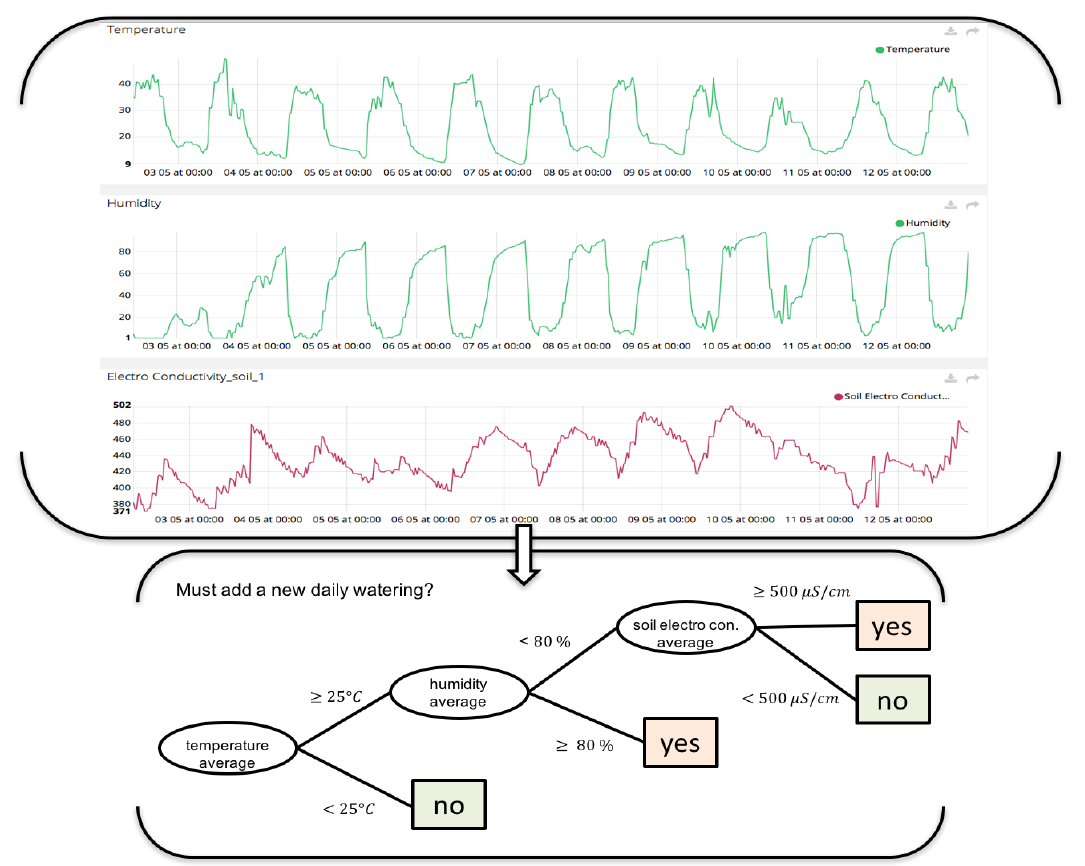
Figure 11. Decision Tree on irrigation control designed by agronomist and integrated on edge